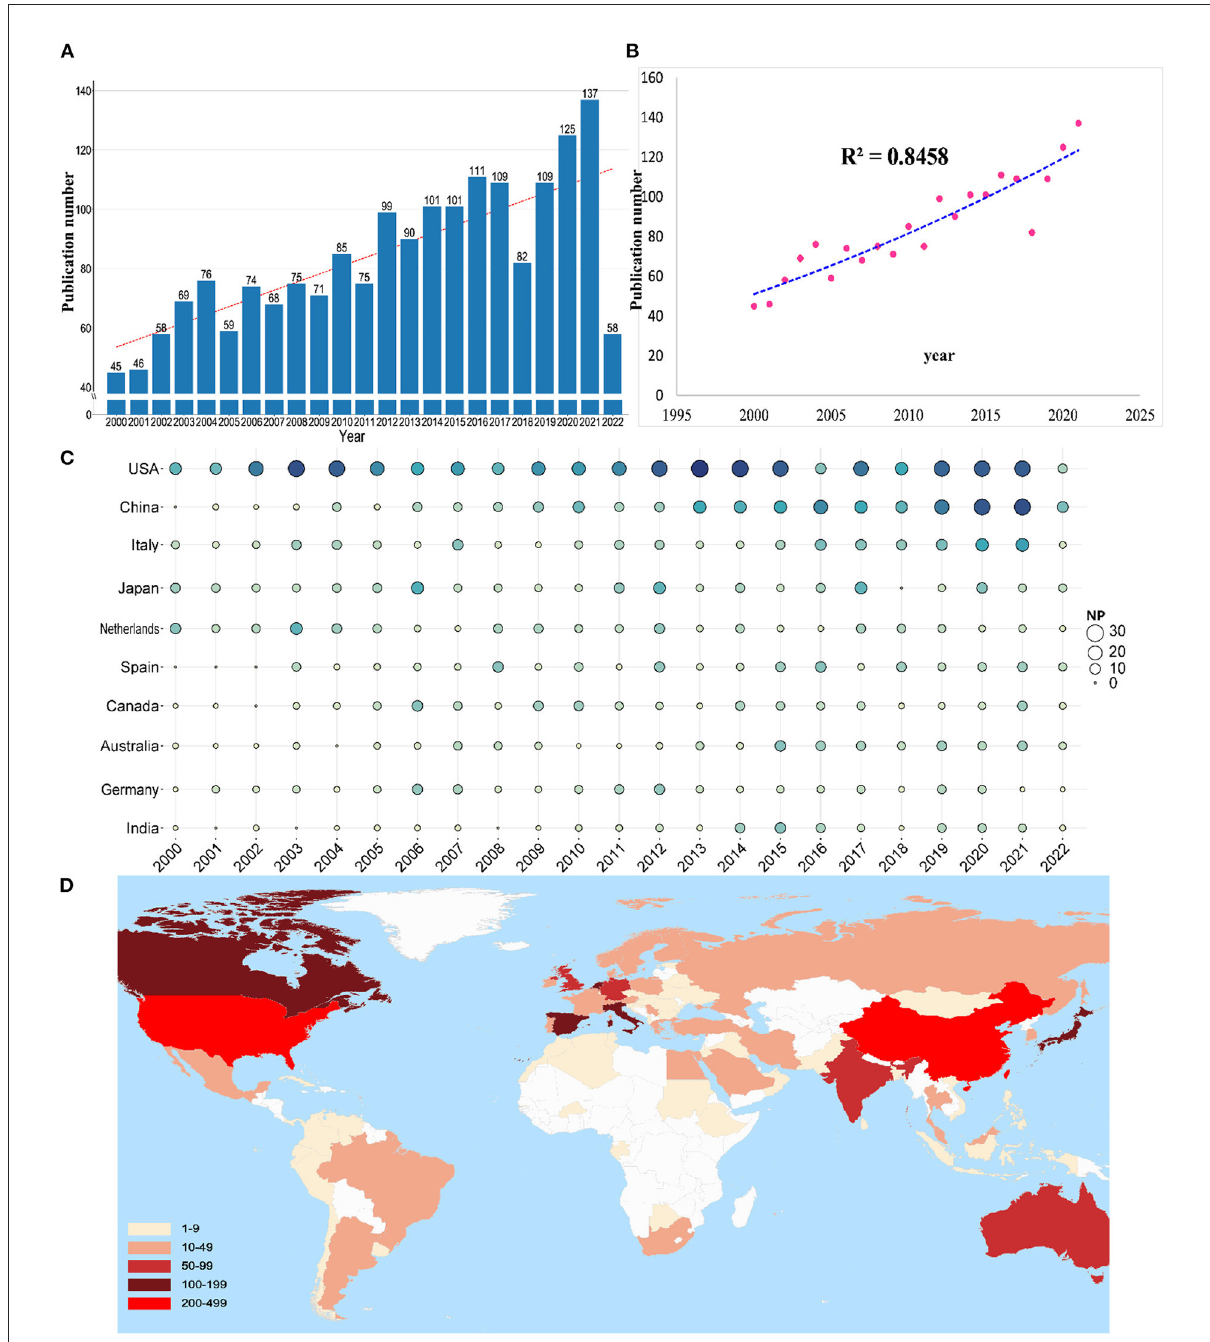
FIGURE1 (A) Number of publications by year over the past 22 years. (B) Curve fitting of the total annual growth trend of publications ( R 2 = 0.8458). (C) Annual output trend of the top 10 productive countries (the size and colors of the circle represent the NP). (D) Publication counts distribution per